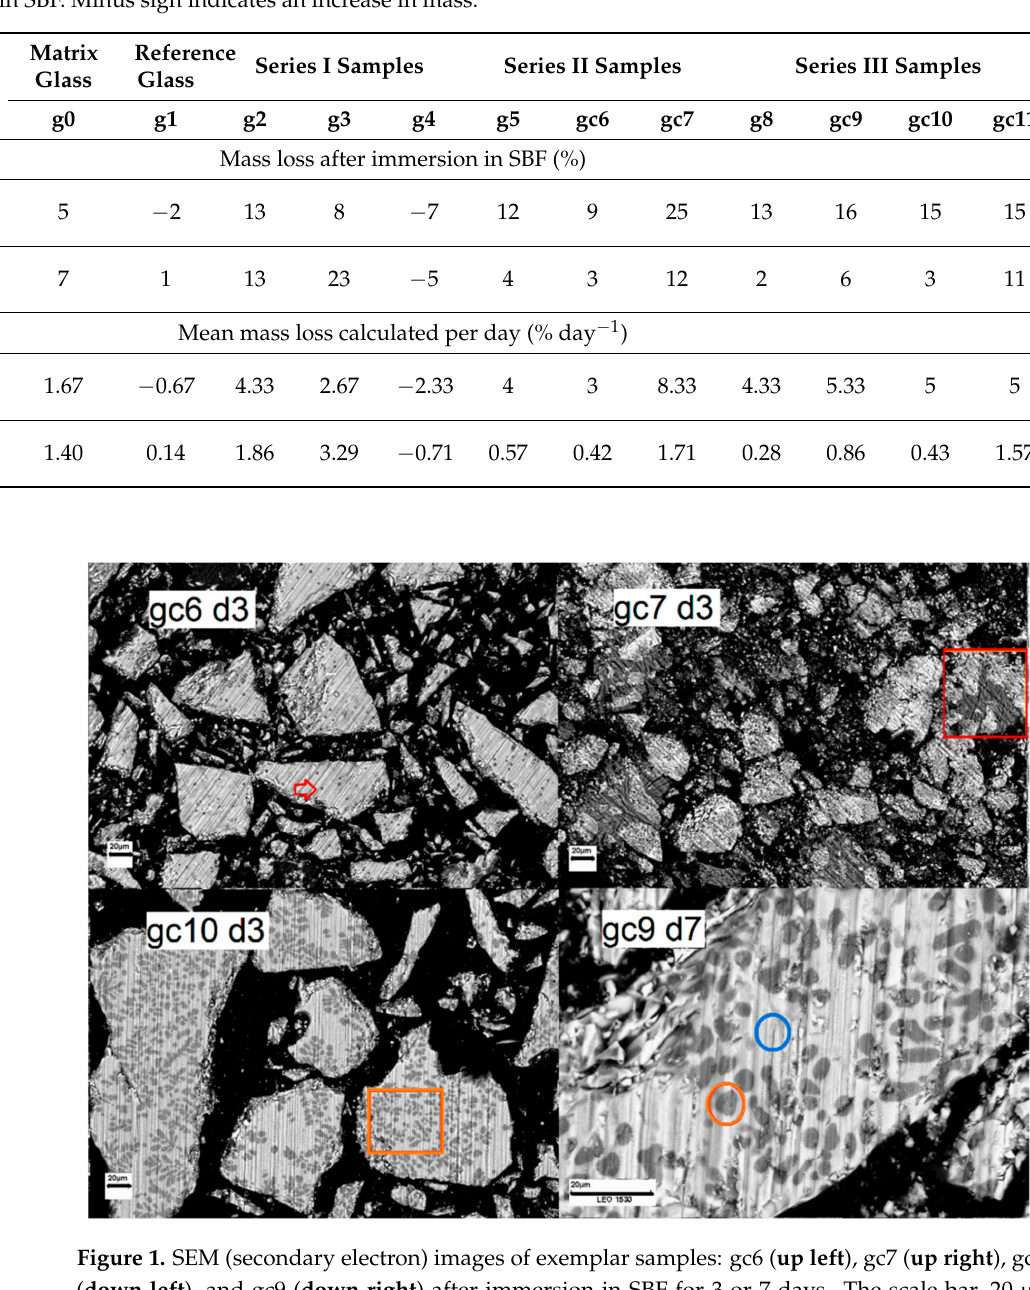
marked by the red frame in Figure 1 up right. The stains are clearly visible for samples: